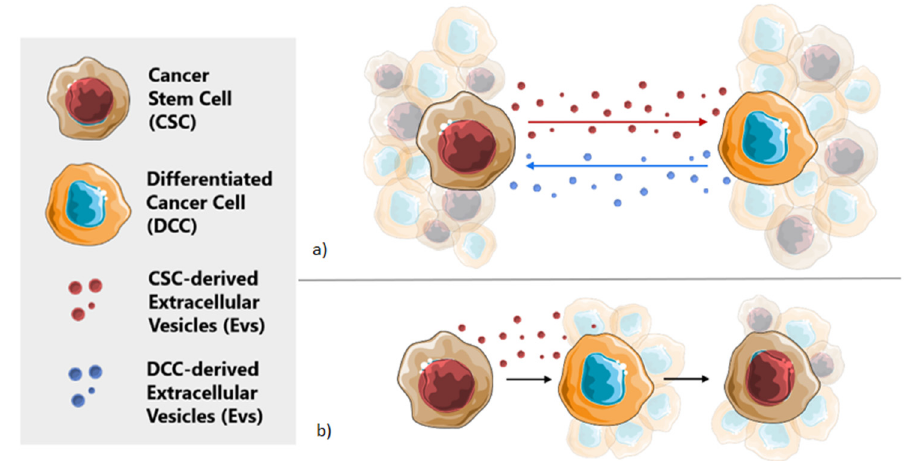
Figure 2. Cellular crosstalk with Extracellular vesicles ( EVs ). ( a ) EV-mediated molecular crosstalk between cancer stem cells (CSCs) and differentiated cancer cells (DCCs) allows for maintaining stable subpopulations. ( b ) Thanks to this cellular communication, DCCs can reverse to the CSCs phenotype when the CSC population decreases and vice versa.